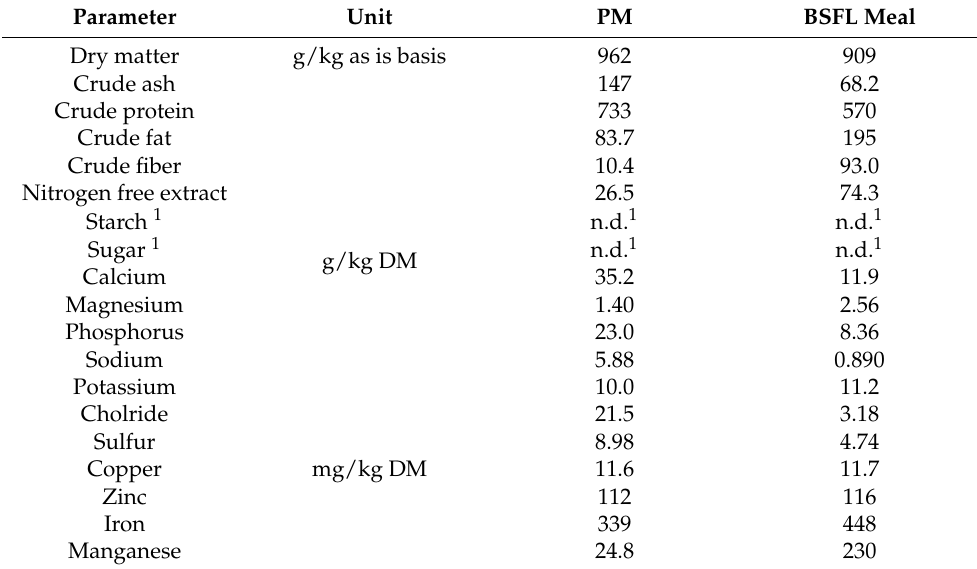
Table 3. Chemical composition of the experimental raw